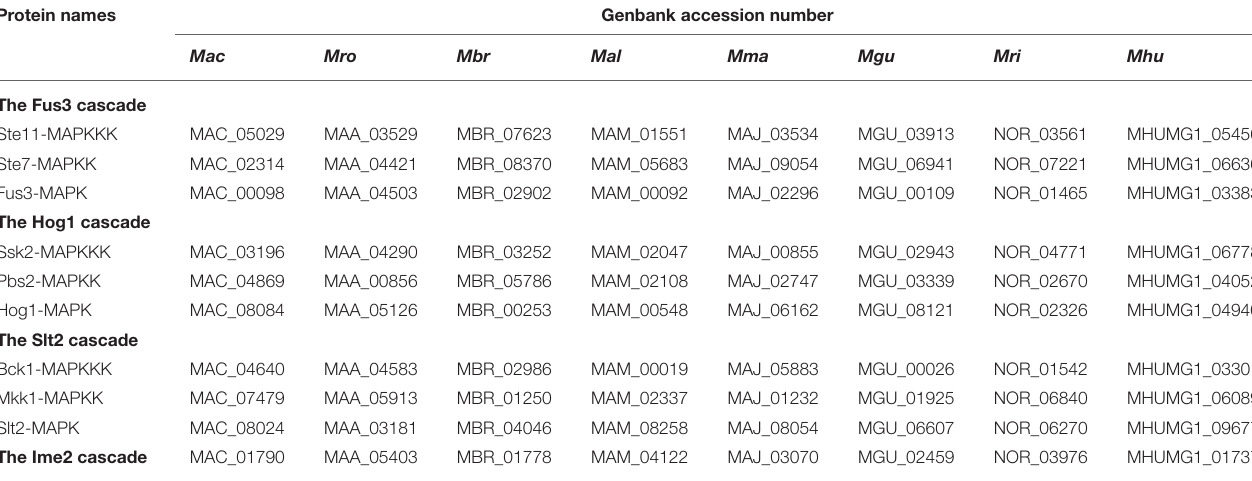
TABLE 1 | Summary of the MAPK cascade components in the Metarhizium